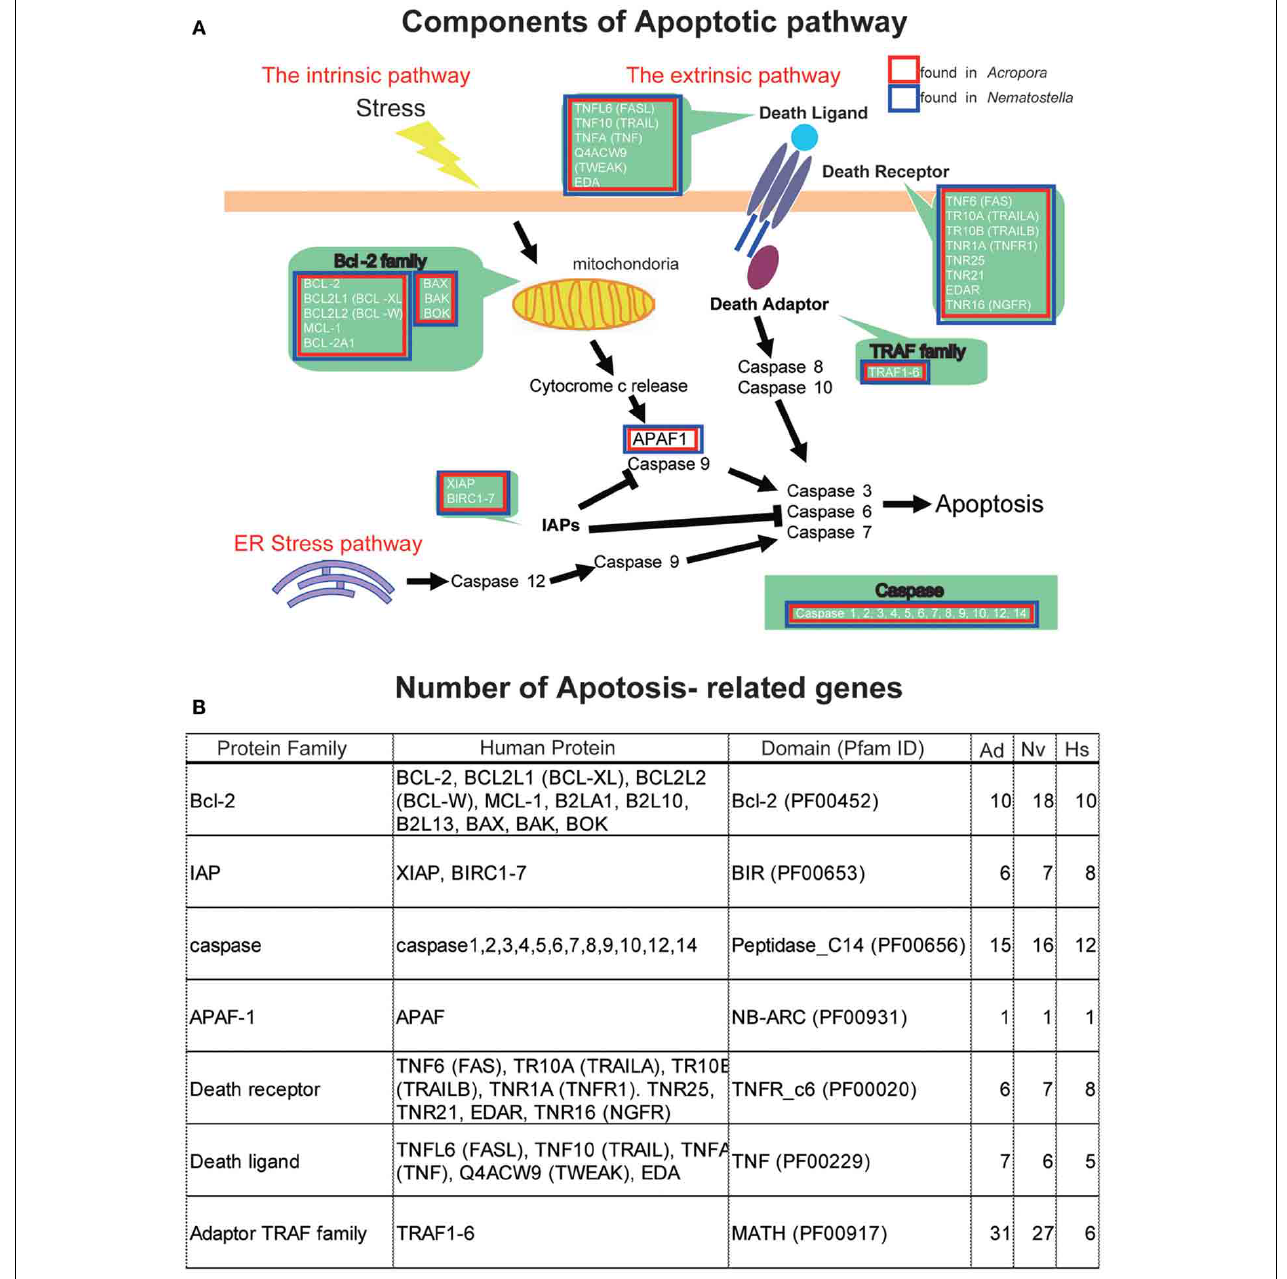
FIGURE 4 | (A) Schematic presentation of cellular components involved in the pathways of apoptosis, based on human genes. The extrinsic pathway, intrinsic pathway, and ER stress pathway are three major pathways of apoptosis. Major families are shown by green background. Families found in the Acropora digitifera genome are boxed by red and those of Nematostella